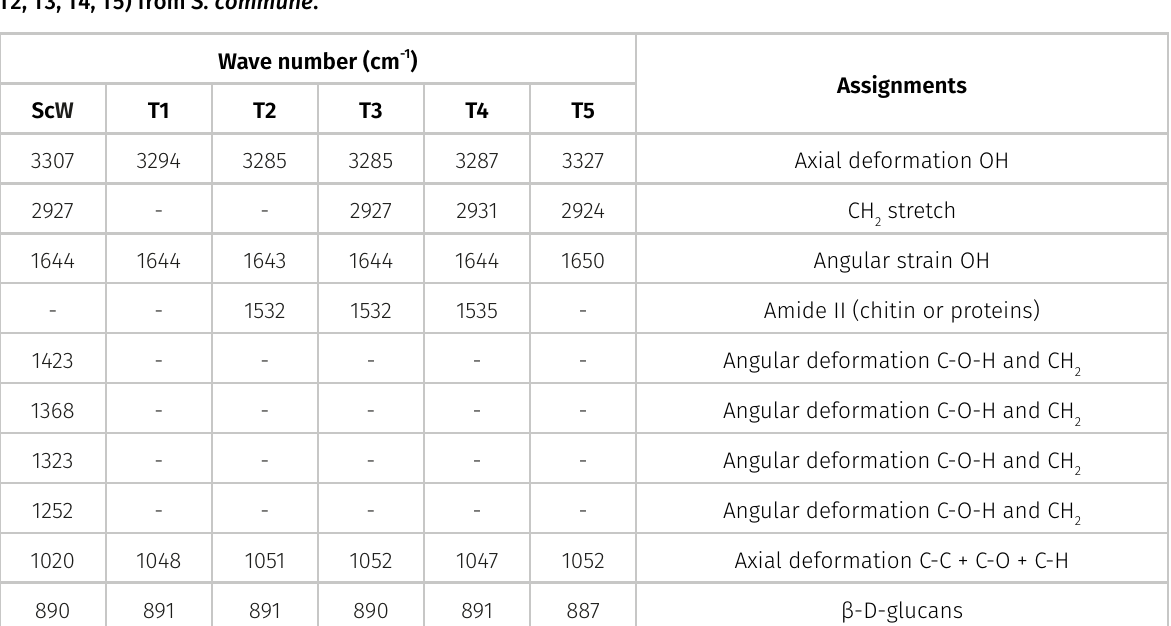
Table II. Wavenumber (cm -1 ) and assignments for polysaccharides extracted from the wild (ScW) and mutants (T1, T2, T3, T4, T5) from S. commune